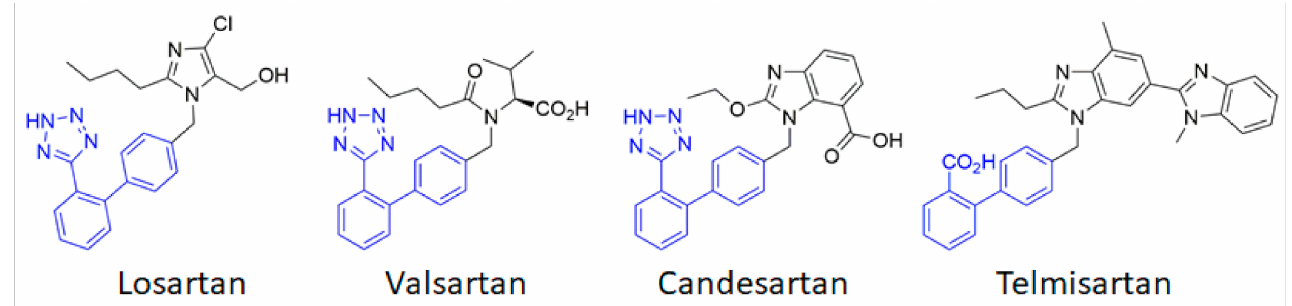
Figure 2. Chemical structures of the main angiotensin receptor blockers (ARB) used in therapeutics. The biphenyltetrazole (or the bioisosteric biphenyl carboxylic acid for telmisartan) is highlighted in